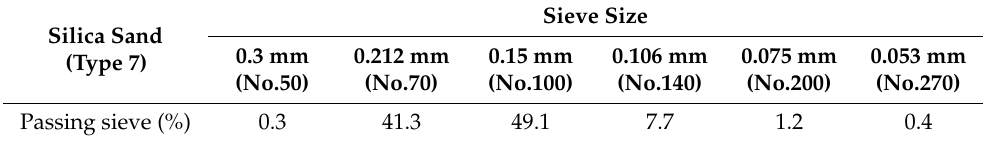
Table 3. Silica sand particle size